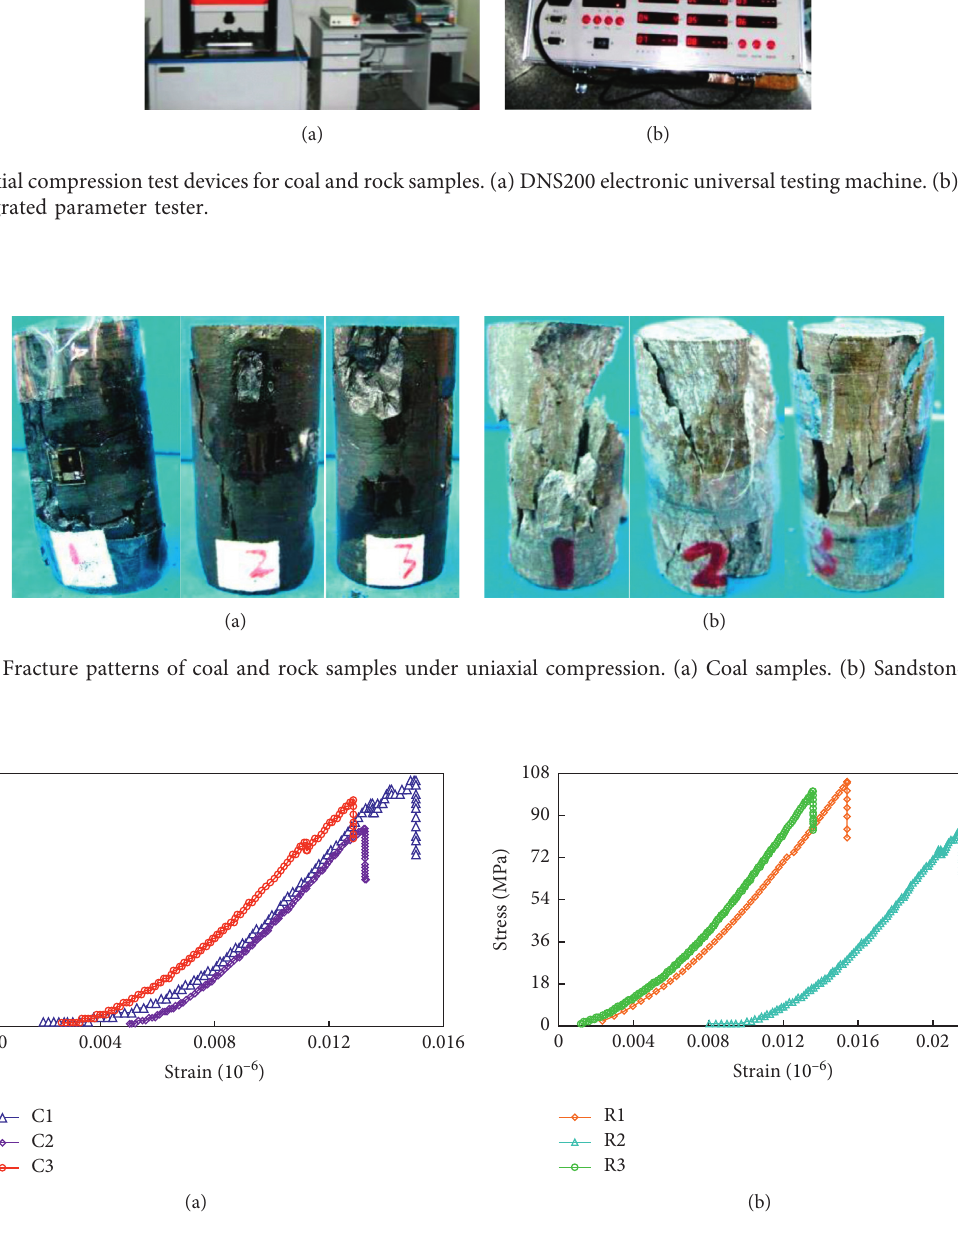
Figure 4: Stress-strain curves of coal and rock samples under uniaxial compression. (a) Coal samples. (b) Sandstone